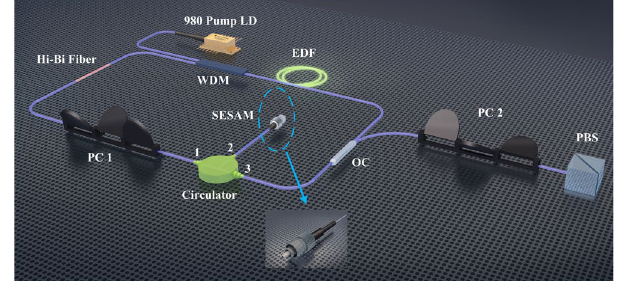
Figure 1. Schematic illustration of the experimental setup. Passively mode-locked fiber laser and polarization- resolved measurement. LD, laser diode; WDM, wavelength division multiplexer; EDF, erbium-doped fiber; SESAM, semiconductor saturable absorber mirror; PC, polarization controller; OC, output coupler; PMF, polarization-maintaining fiber; PBS, polarization beam